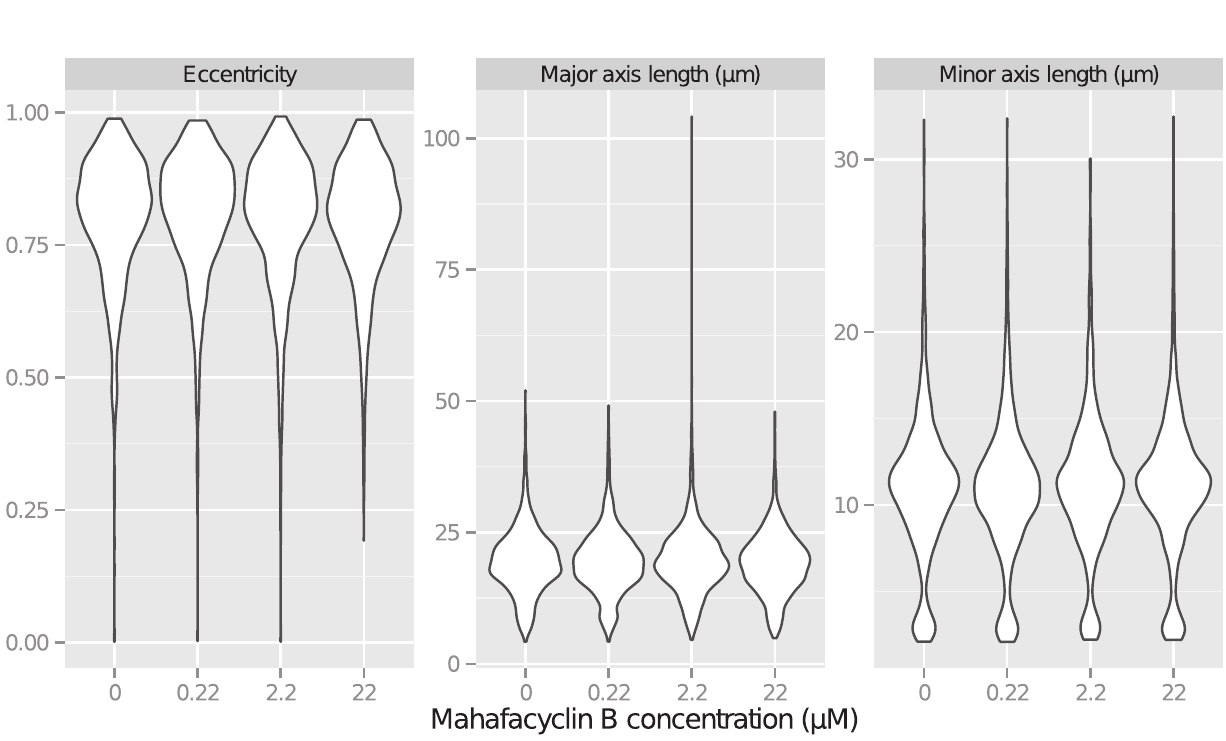
Fig 3. Mahafcyclin B alters the morphology of CHO-K1 cells. Morphology was measuredusing continuous boxplotsfor eccentricity, major- axis length, and minor-axislength of each cell in response to mahafacyclin B.